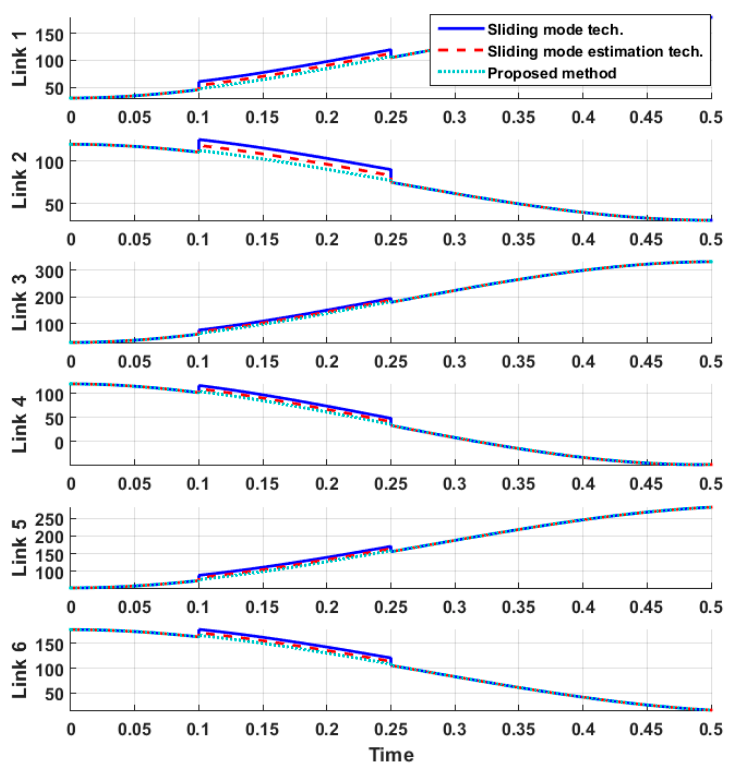
Figure 15. Trajectory in the faulty condition for the proposed algorithm, sliding mode estimation technique, and classical sliding mode method.